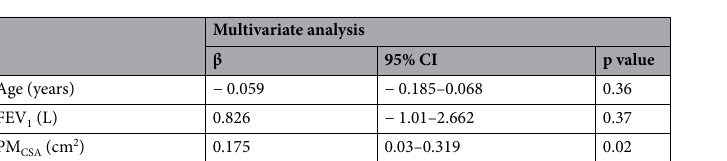
˙ VO 2 at peak exercise and age, FEV 1 , and PM CSA as